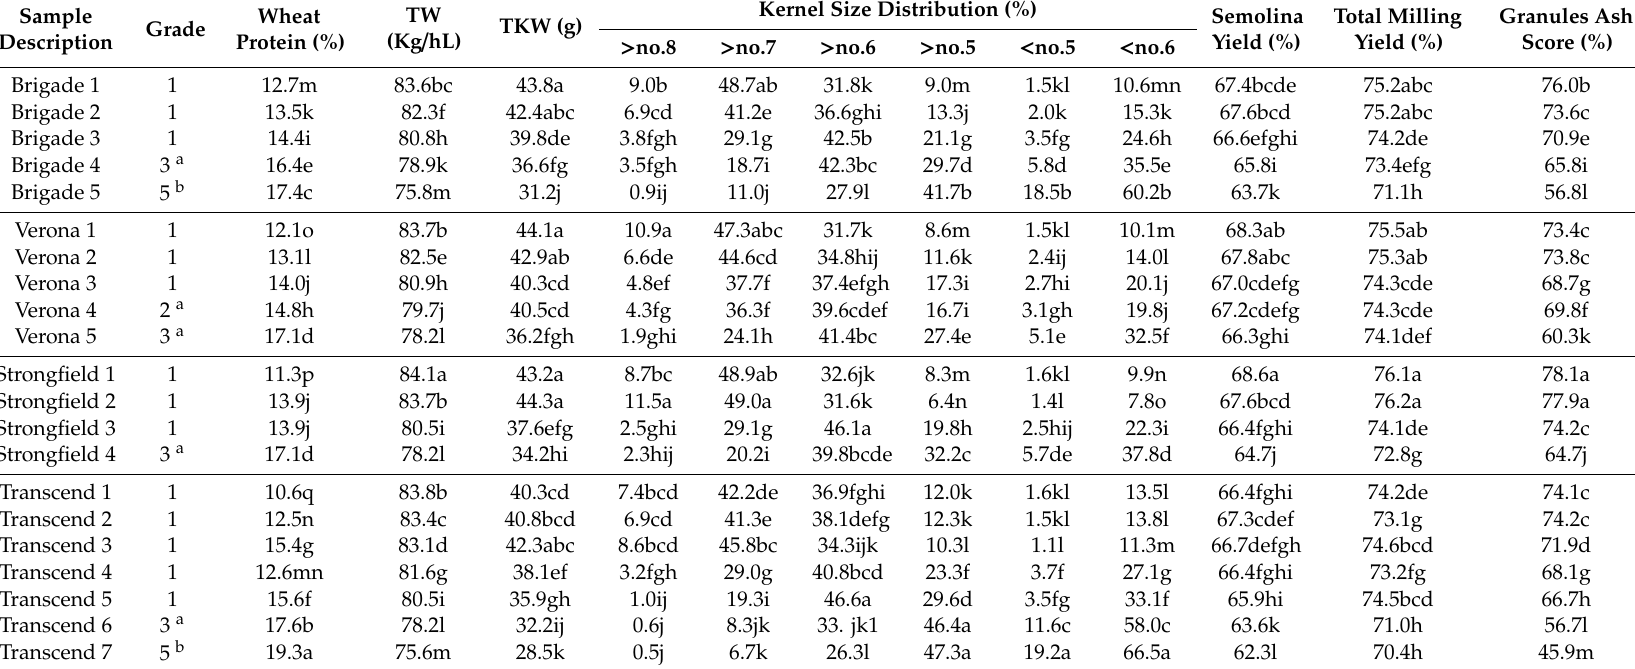
Table 2. Physical and milling properties of varietal composites prepared from 2017 harvest samples (set